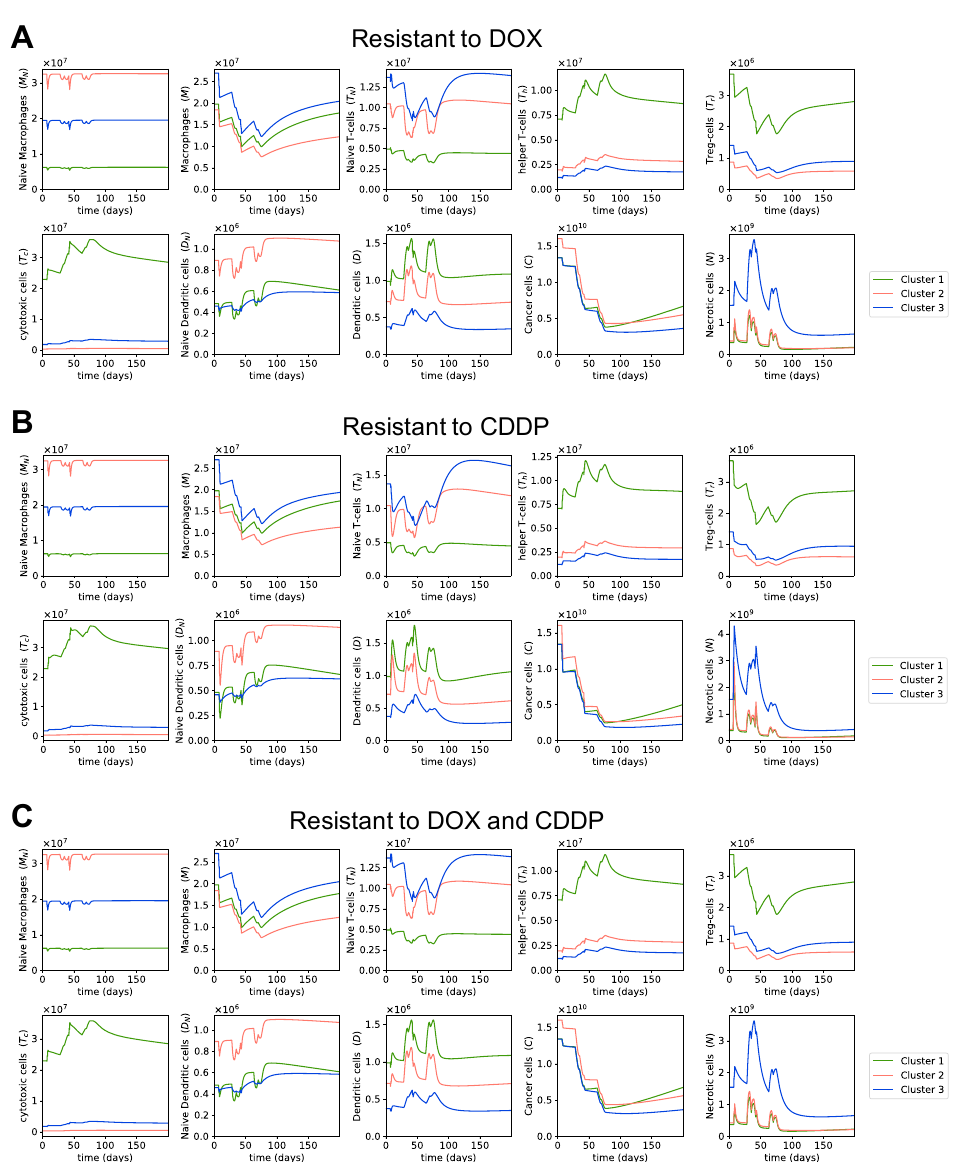
Figure 5. Dynamics in chemotherapy-resistant cells with MAP treatment. Sub-figures ( A – C ) show the dynamics of immune, cancer, and necrotic cells in osteosarcoma during the MAP treatment and a few months after treatment when cancer cells are resistant to doxorubicin, cisplatin, and both doxorubicin and cisplatin,